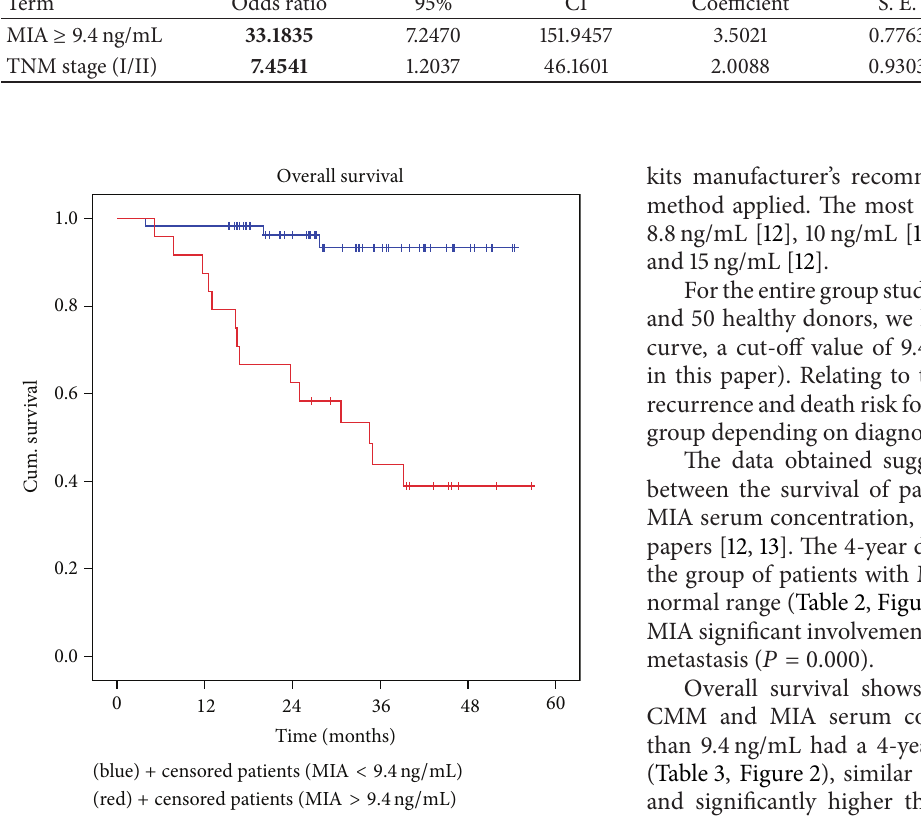
Figure 3: Kaplan-Meier overall survival for all stages I and II melanoma patients according to MIA serum concentration. Blue line: MIA serum concentration < 9.4 ng/mL; red line: MIA serum concentration ≥ 9.4 ng/mL; 𝑃 = 0.000